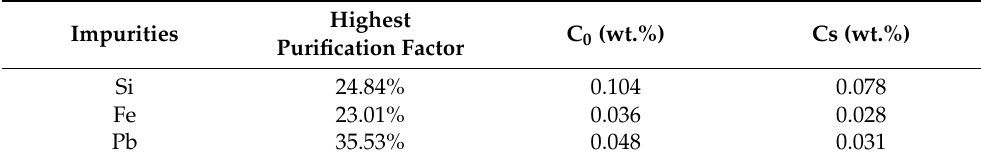
Table 4. Concentration of impurities in the first zone (1) before and after crystallization.